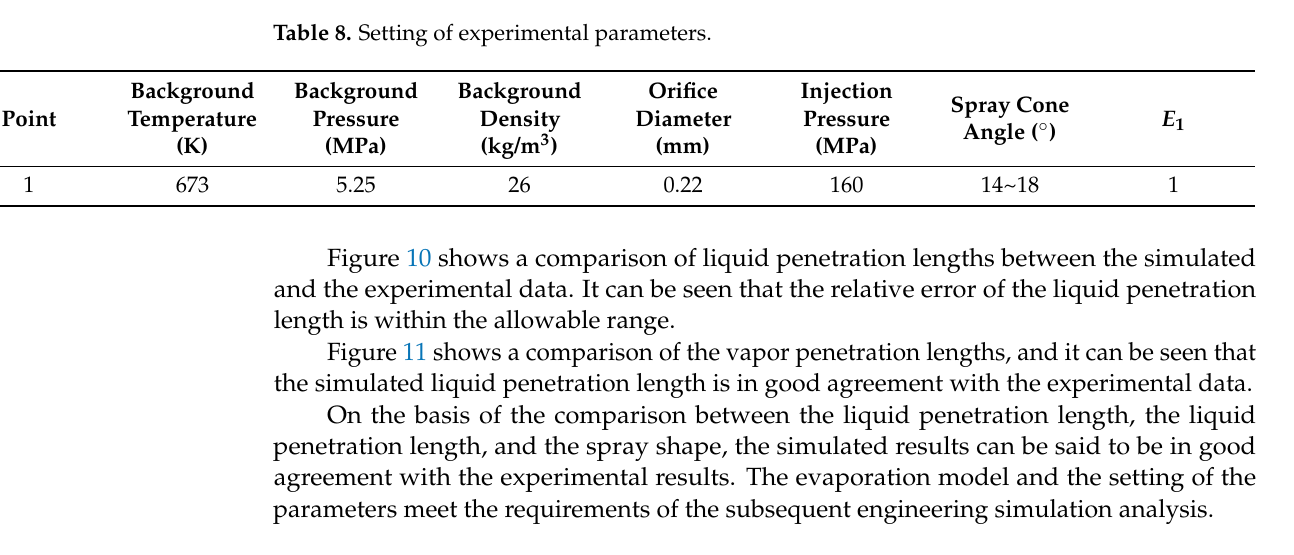
tion; ( b ) Liquid-phase spray of experiments. ( b ) Liquid-phase spray of experiments.